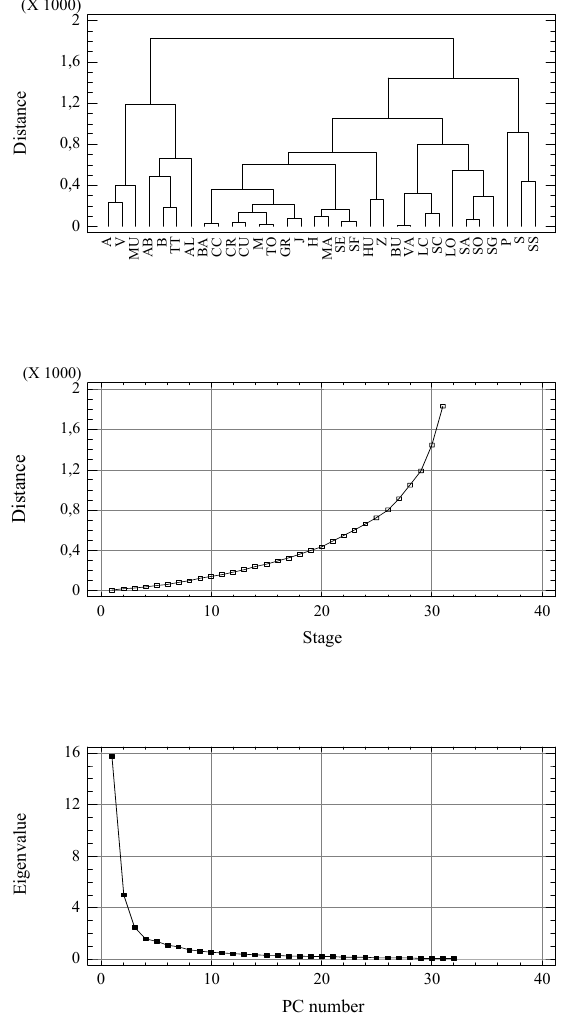
Fig. 3. As Fig. 2, for